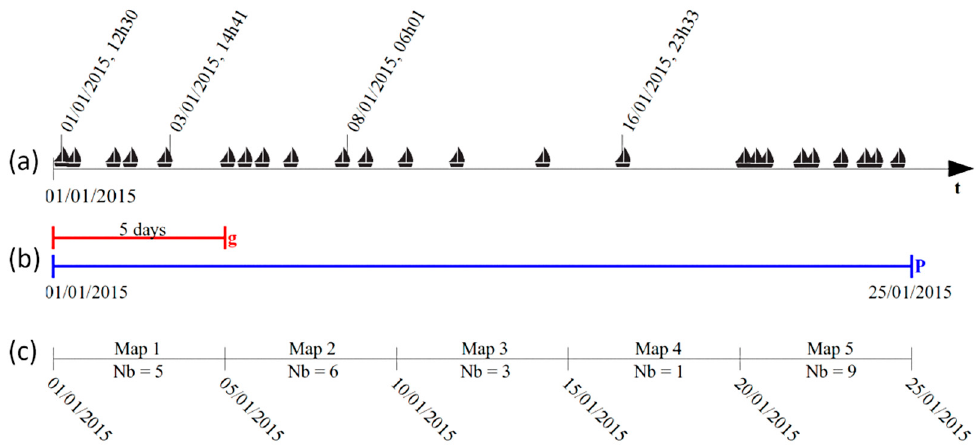
Figure 9. Simplified example of cumulated temporal maps creation; ( a ): boat passage in time, ( b ): the period and the granularity, ( c ): maps temporal topology and the number of boats recorded in each one.